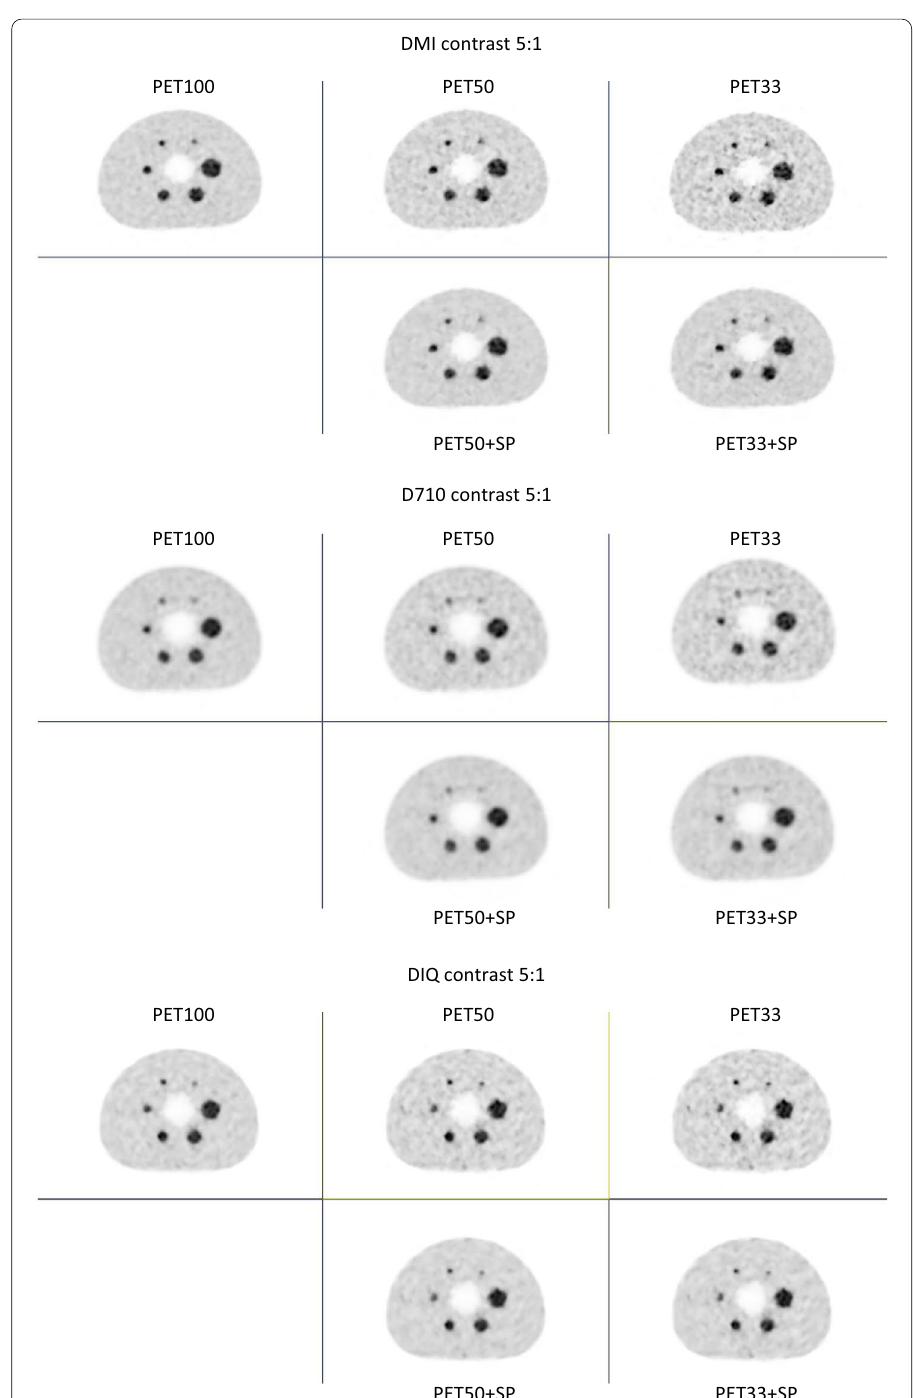
Fig. 1 Images from the IEC phantom acquisition for a contrast of 5:1, for each PET systems (Top image: DMI; Middle image: D710 and bottom image: IQ4), acquisition time (1st column: PET100, 2nd colomn: PET50 and 3rd column: PET33) and the application of SubtlePET (2nd row of each